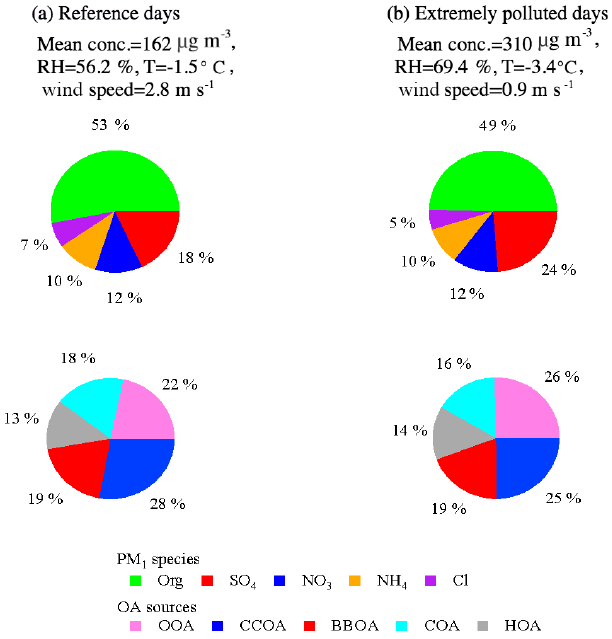
Figure 4. Relative contributions of NR-PM 1 species and OA sources (OOA, CCOA, BBOA, COA, and HOA) on reference days (a) and extremely polluted days (b) . Extremely polluted days are defined as days with a NR-PM 1 daily average mass concentra- tion higher than the 75th percentile (237.3µgm − 3 ), and the remain- ing days are referred to the reference days. Data collected during the Chinese Spring Festival are excluded to eliminate the influence of the change in emission patterns during the